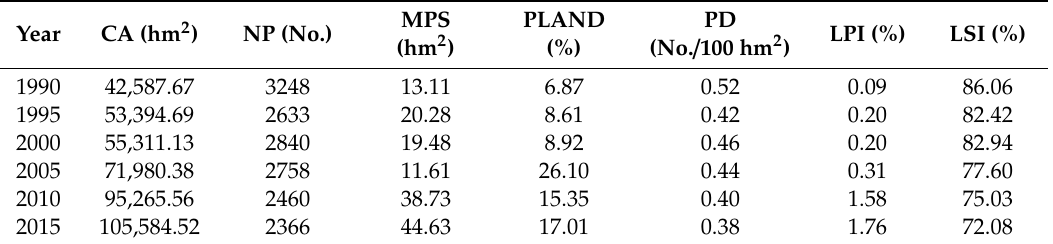
Table 4. Landscape pattern indexes and their changes in rural residential areas in Shanghai.